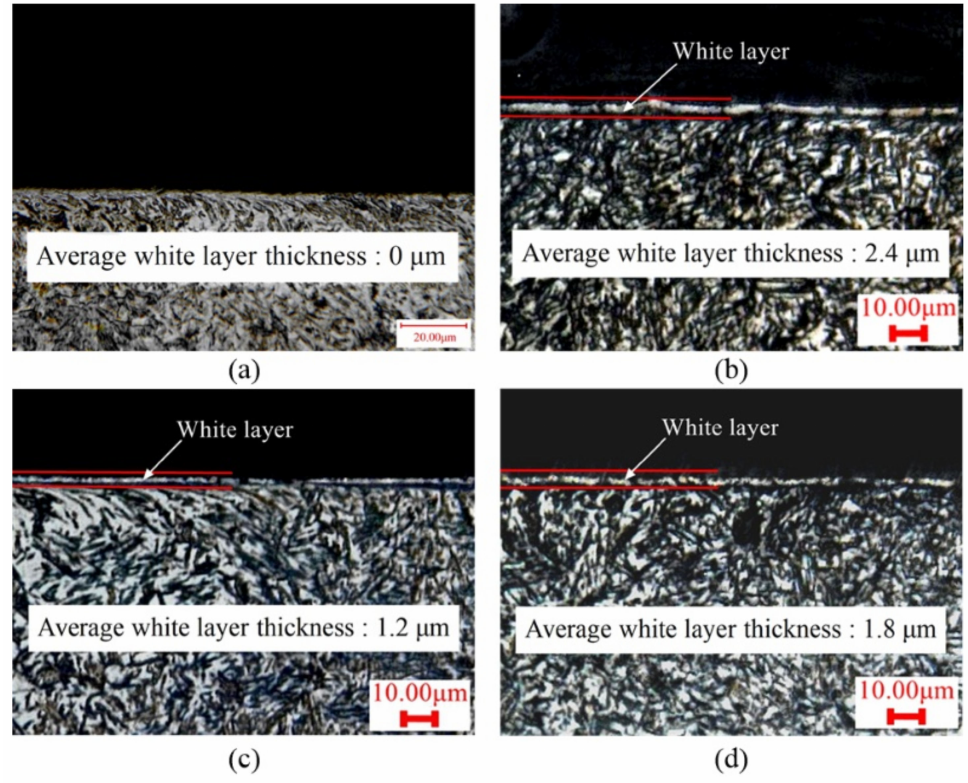
Figure 9. The microstructure of AerMet100 steel generated in experiments: ( a ) Case 1, ( b ) Case 4, ( c ) Case 8, ( d ) Case 9.